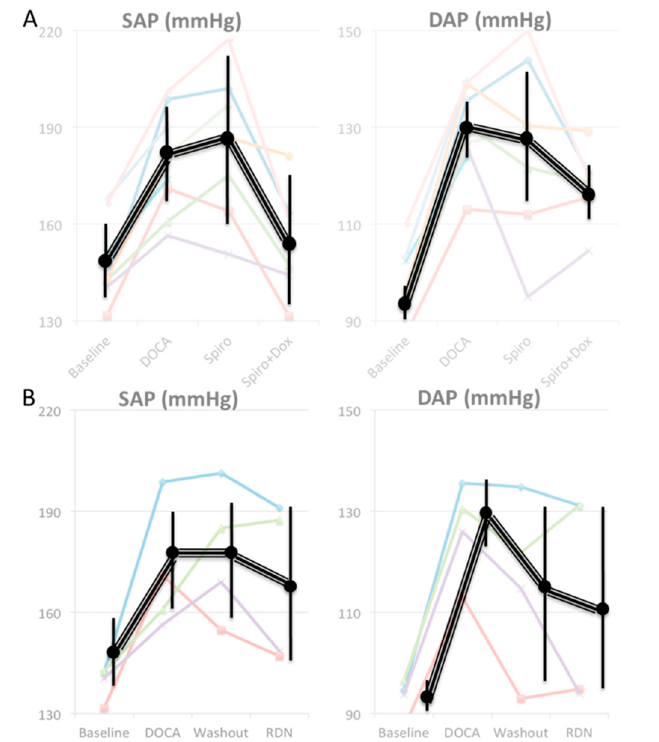
Figure 3. Systolic (SAP) and diastolic (DAP) arterial pressures in a minipig model of 11-deoxycorticosterone (DOCA)-induced hypertension (HTN). ( A ) Effect of the antihypertensive medication ( n = 6). ( B ) Effect of the denervation renal (DNR) ( n =